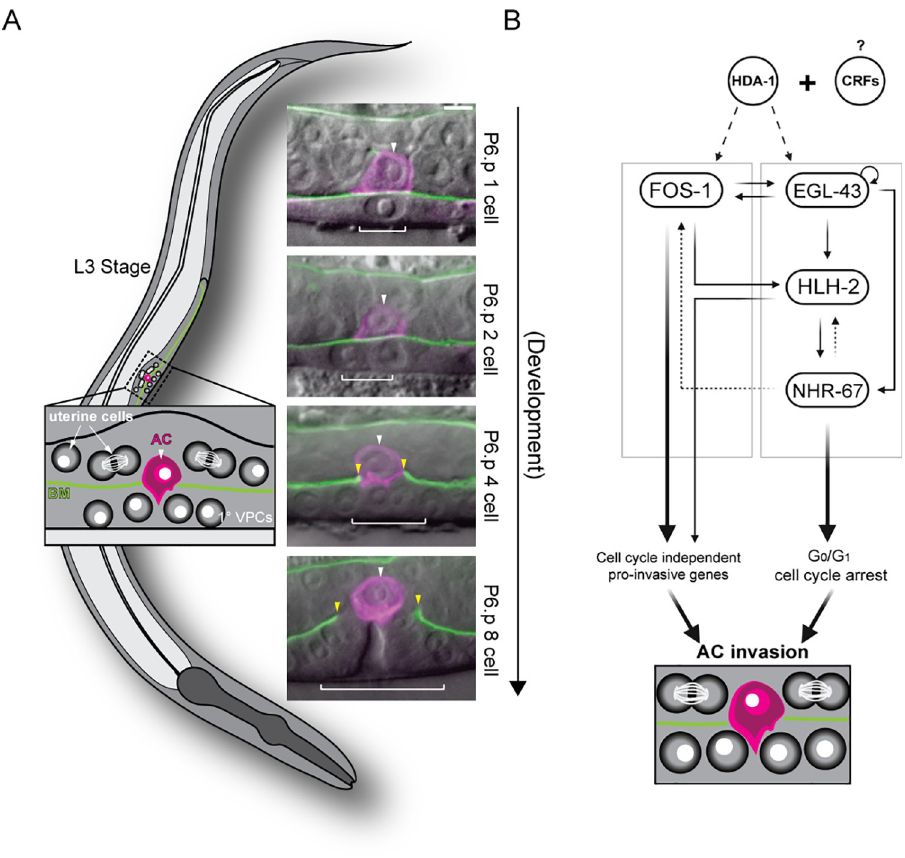
Fig 1. Summary of C . elegans AC invasion through the underlying BM. (A) Schematic depicting AC invasion in the mid-L3 stage of C . elegans development (left) and micrographs demonstrating the coordination of AC (magenta, cdh- 3p :: PH :: mCherry )invasion through the BM (green, laminin :: GFP ) with primary vulval development in the uterine- specific RNAi hypersensitive background used in the chromatin factor RNAi screen. The fluorescent AC-specific membrane marker and BM marker are overlaid on DIC in each image. White arrowheads indicate ACs, yellow arrowheads indicate boundaries of breach in the BM, and white brackets indicate 1˚ VPCs. Scale bar, 5 μ m. (B) Overview of the transcription factor GRN governing AC invasion [22, 24], which consists of cell cycle-independent ( fos-1 ) and dependent ( egl-43 , hlh-2 , and nhr-67 ) subcircuits, which together with hda-1 promote pro-invasive gene expression and maintain cell cycle arrest in the